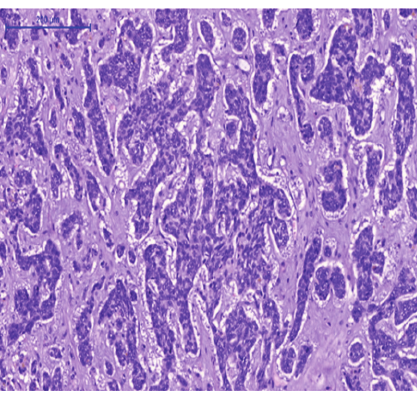
Figure 1: HE-staining. Hepatic BSCC showing tumor infiltration, islands, and strands with surrounding retraction